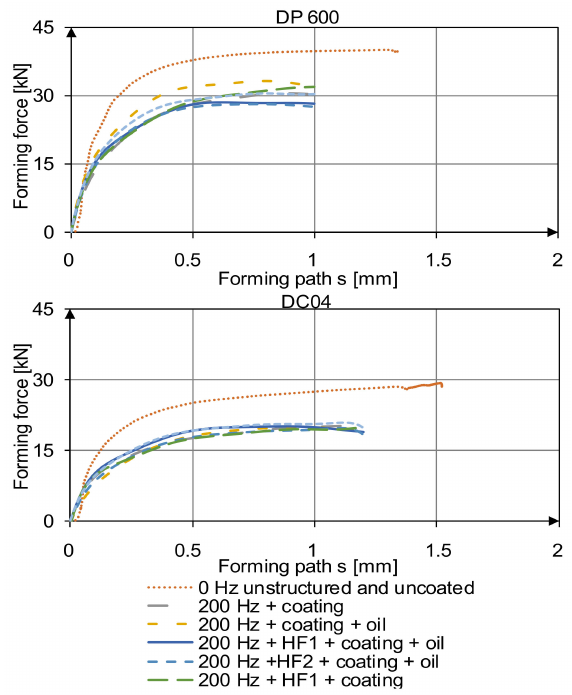
Figure 6. Forming force of DP 600 samples dependent on oscillating overlay, coating, structuring and oiling ( above ). Forming force of DC04 samples dependent on oscillating overlay, coating, structuring and oiling ( below